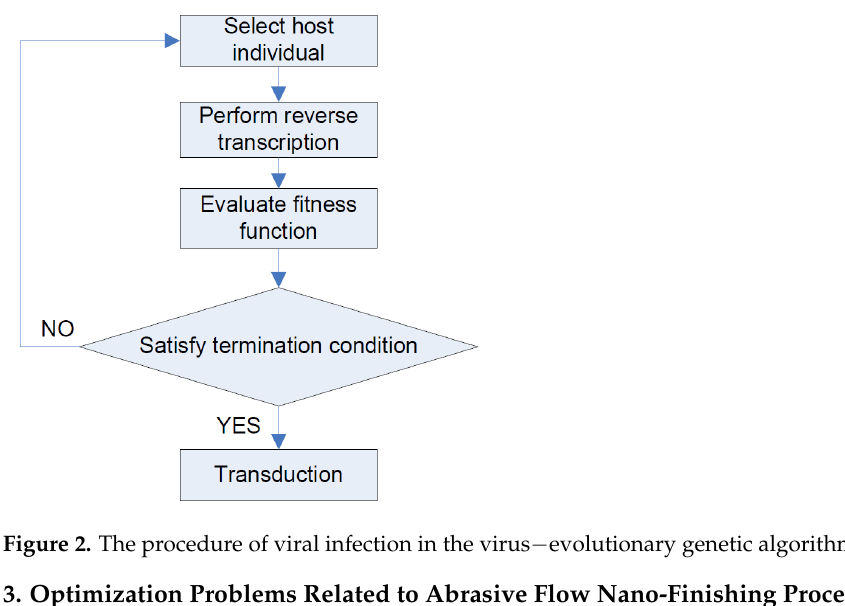
Figure 1. ( a ) Transduction operation for the creation of a virus individual, ( b ) reverse transcription operation for infecting an individual with a virus, ( c ) infected individual after the reverse transcription operation performed by the virus, and ( d ) partial transduction operation for changing the virus scheme.